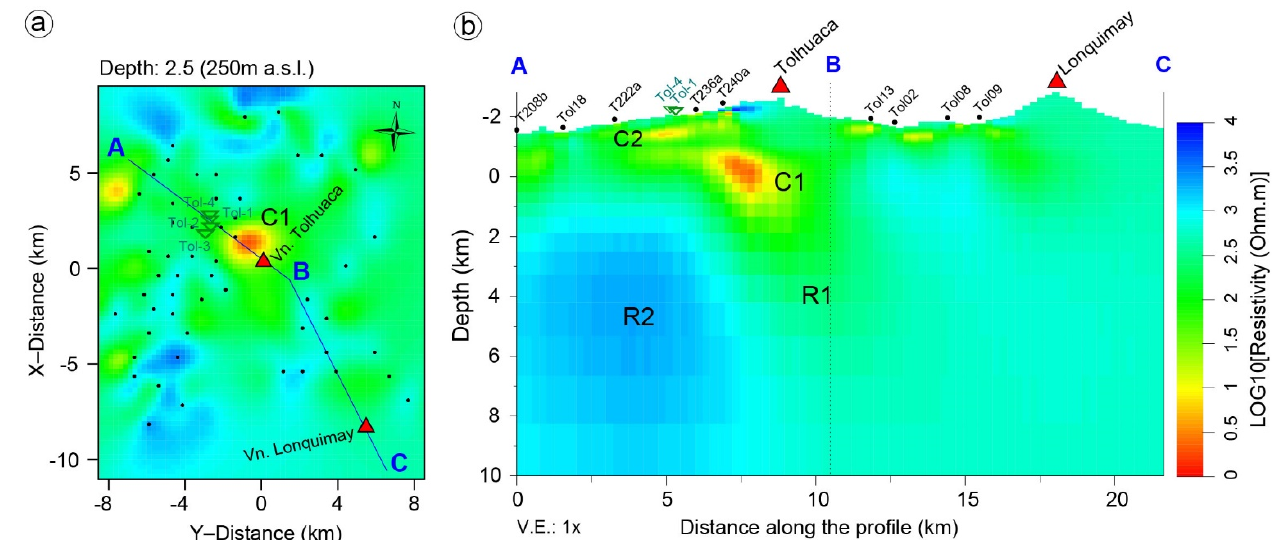
Figure 5. The preferred MT resistivity model shown by vertical slice along profile ABC. ( a ) Horizontal plan views at 2.5 km (250 m a.s.l.) depth. ( b ) AB northwest diagonal cut along the NW flank of Tolhuaca volcano, passing through the well exploration site. BC N-NW diagonal cut connecting Tolhuaca and Lonquimay volcanoes. Dashed black lines in the vertical sections show the intersection of the profiles. The black dots and green inverted triangles on the vertical and horizontal sections are the locations of MT sites and exploration wells, respectively.